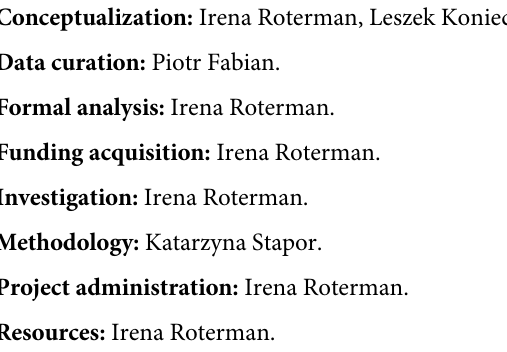
tion shown in Fig 1B; SI Table 3 . List of Mus Musculus proteins under consideration with dis- ordered fragments; SI Table 4 . The values of parameter RD and of optimal parameter K corresponding to the smallest value D (O|M) (calculated in the FOD-M model) for a struc- KL tural unit (chain/domain) and